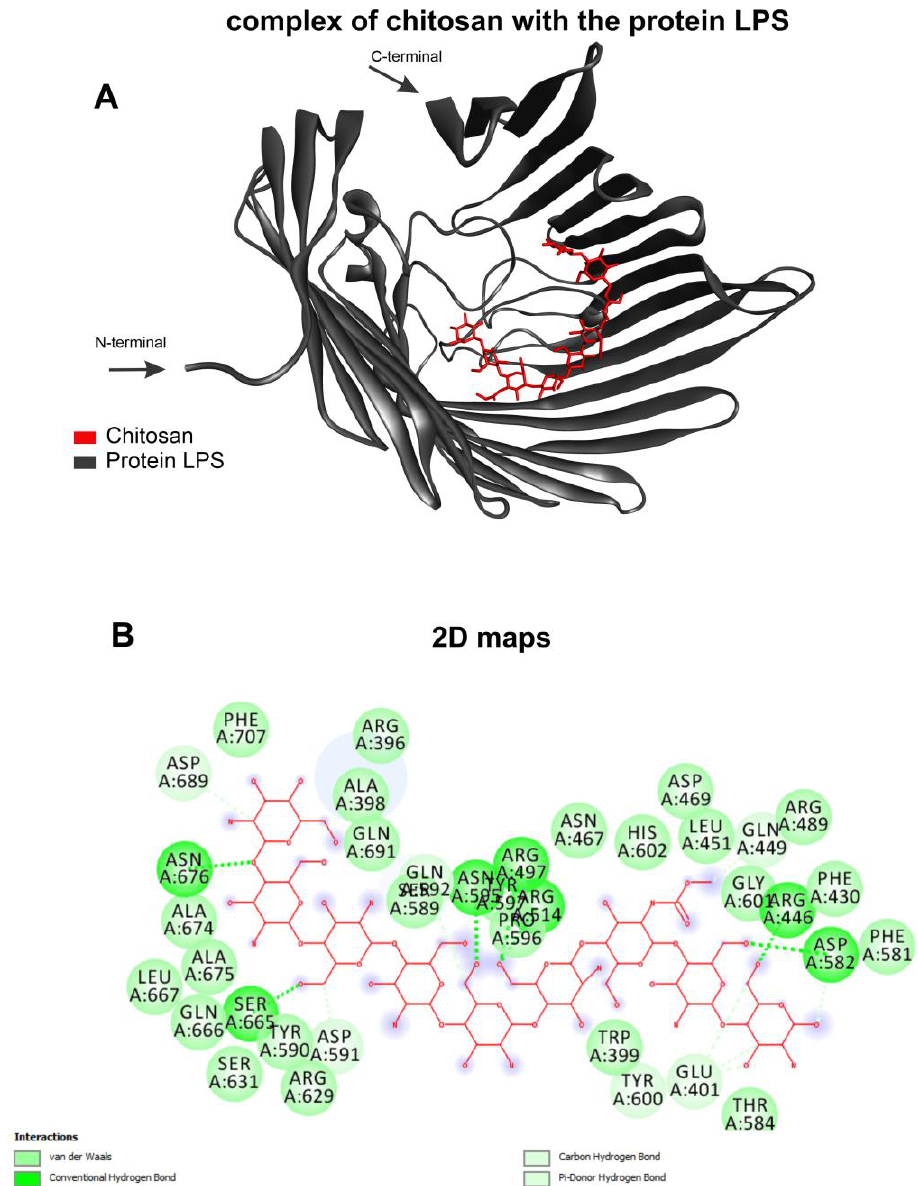
Figure 3. Molecular docking calculations. Chitosan (red) complexed with protein LPS (gray) ( A ) and 2D maps of molecular interactions with amino acids ( B ) of Acinetobacter baumannii.